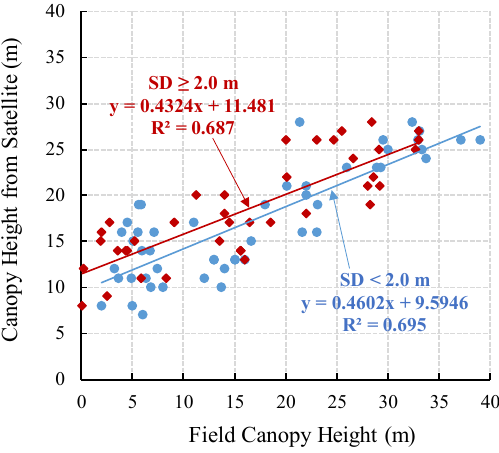
Figure 5. Scatter plots for the two groups of evaluations sites: one is with the standard deviation (SD) of satellite canopy height within the site-centered 3 × 3 window smaller than 2.0 m (i.e., SD <2.0, dark red diamonds) and the other group with SD >2.0 (blue circles).